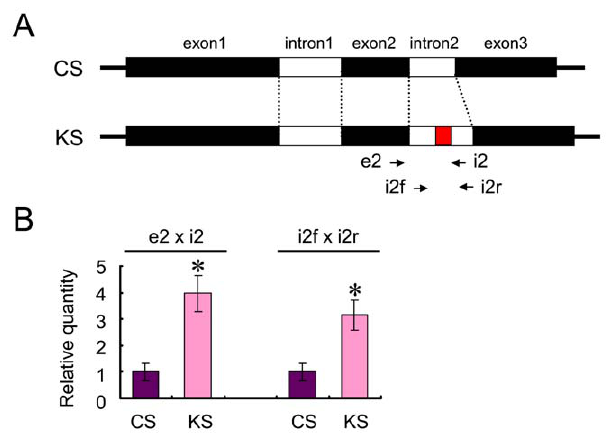
Figure 6. Detection of unspliced second intron in Koshu berry skin. (A) Primer map to detect unspliced second intron. (B) RT-PCR analysis using two primer sets. Total RNAs extracted from berry skin of Cabernet Sauvignon (CS) and Koshu (KS) were used. *p , 0.05 as compared with CS.